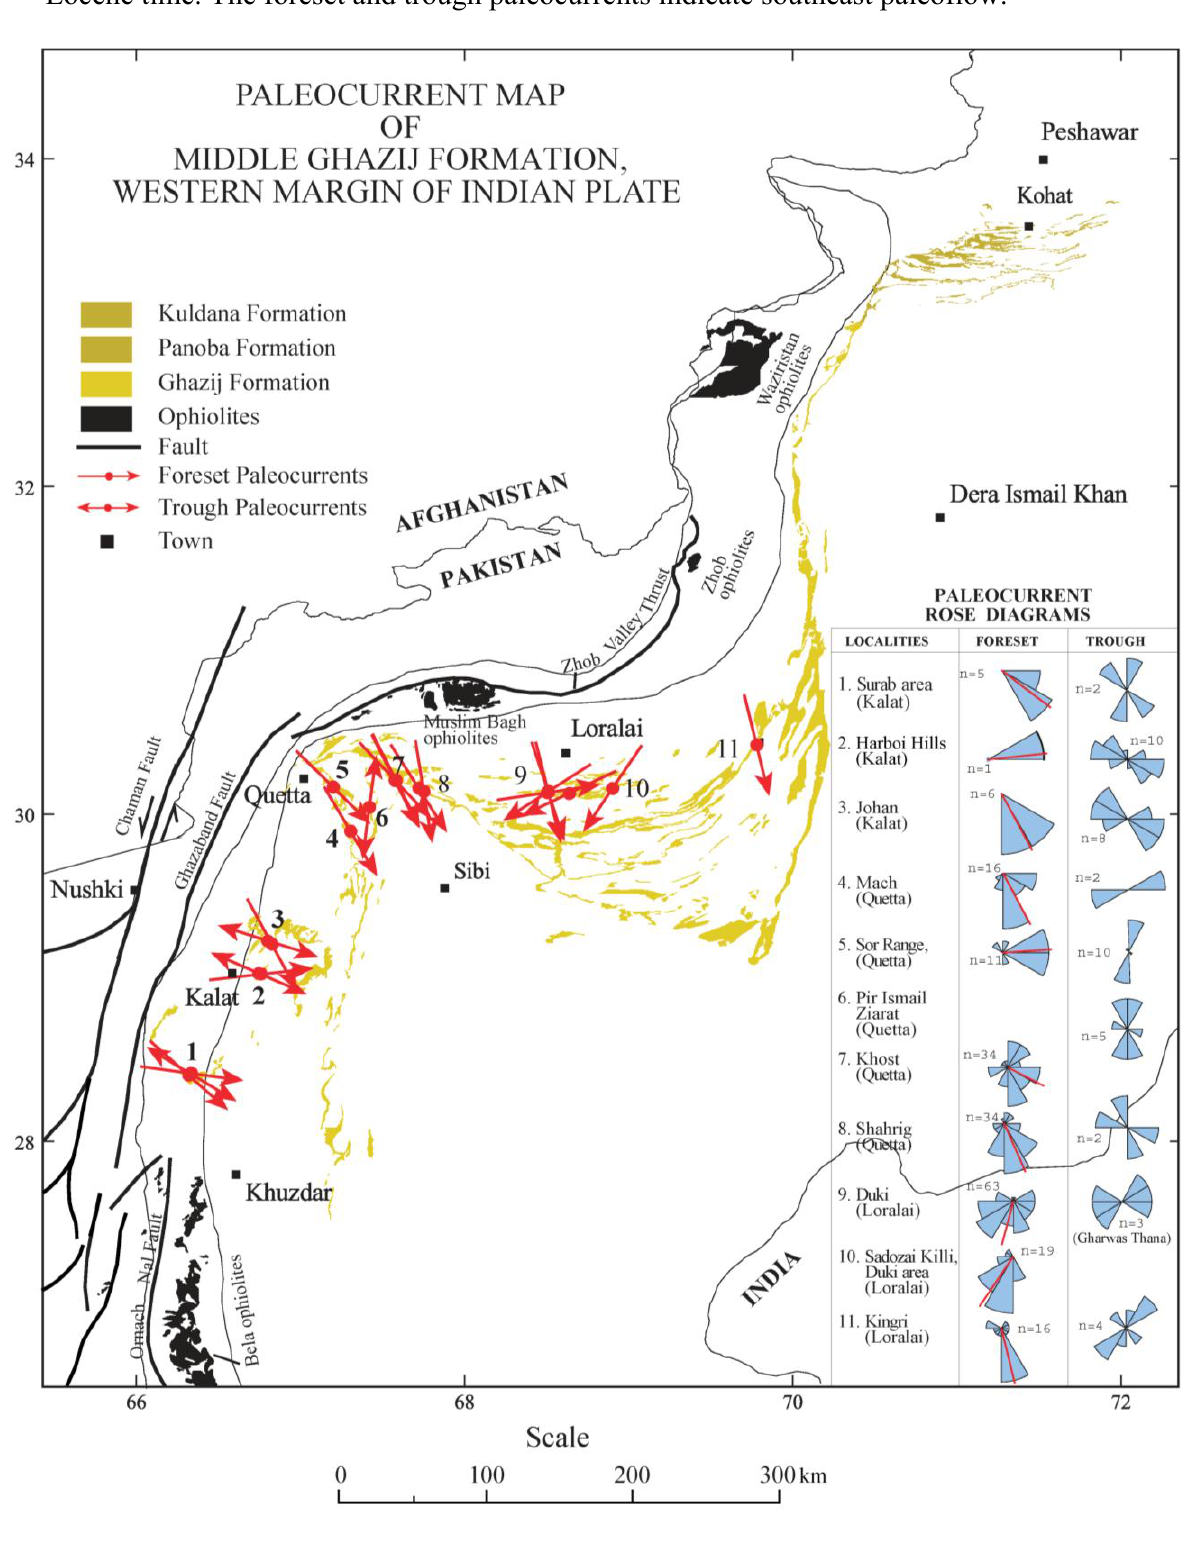
Figure A6. Paleocurrent map of middle Ghazij Formation showing dominant paleoflow and sediment transport directions along western margin of the Indian Plate during early Eocene time. The foreset and trough paleocurrents indicate southeast